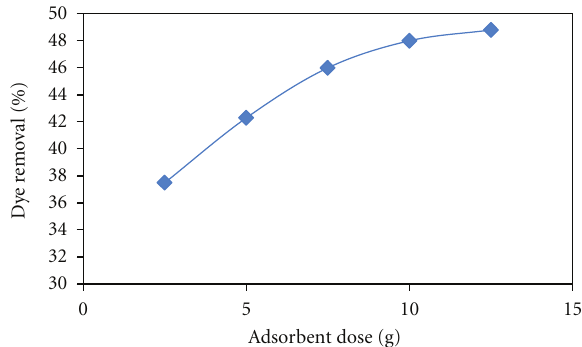
F 5: Effect of adsorbent dose on percentage dye removal, 100ppm dye concentration, 303K, pH = 5 of AO-7.